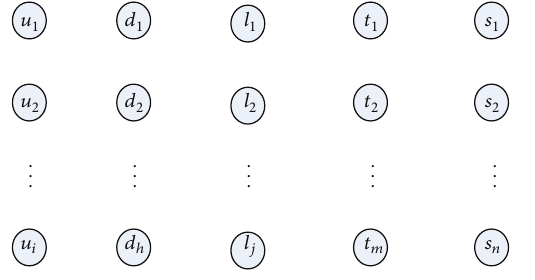
Figure 6: Network diagram model.